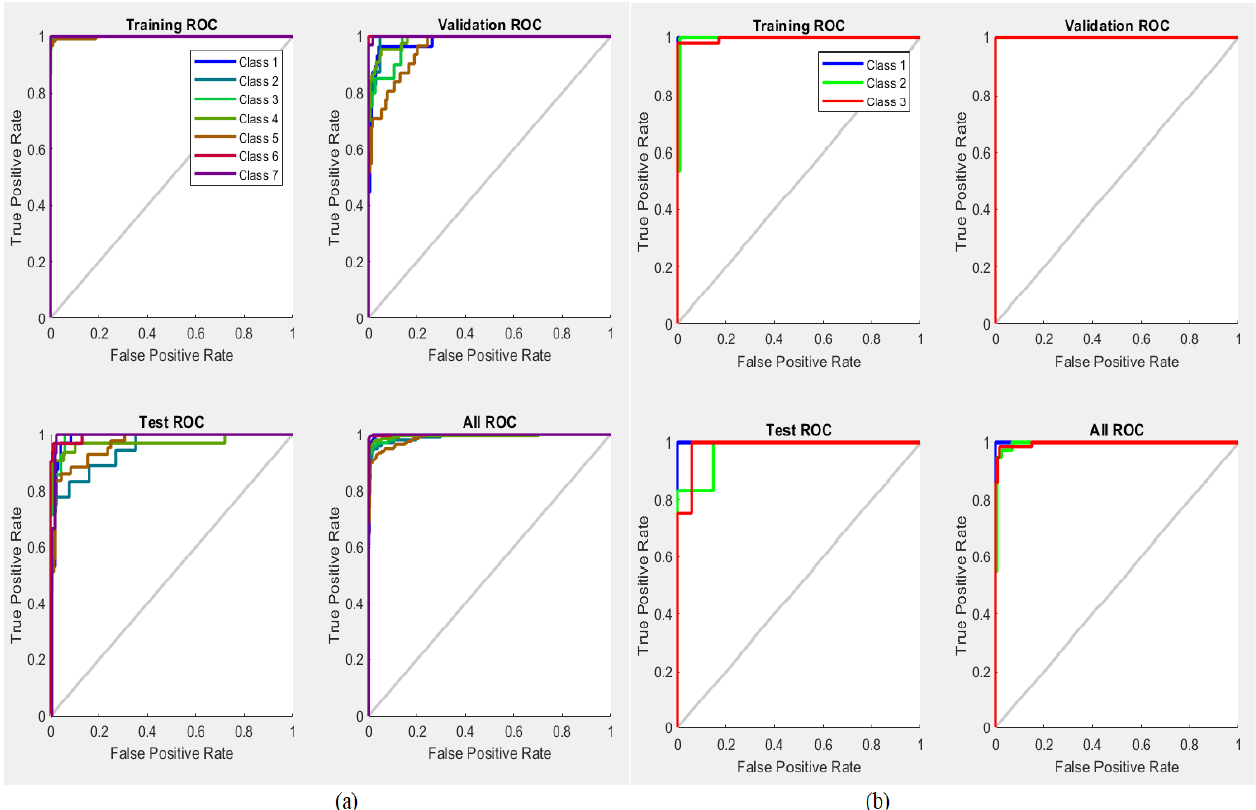
Figure 17. Displays the ROC of the ANN algorithm: ( a ) ISIC 2018 data set and ( b ) PH2 data set.